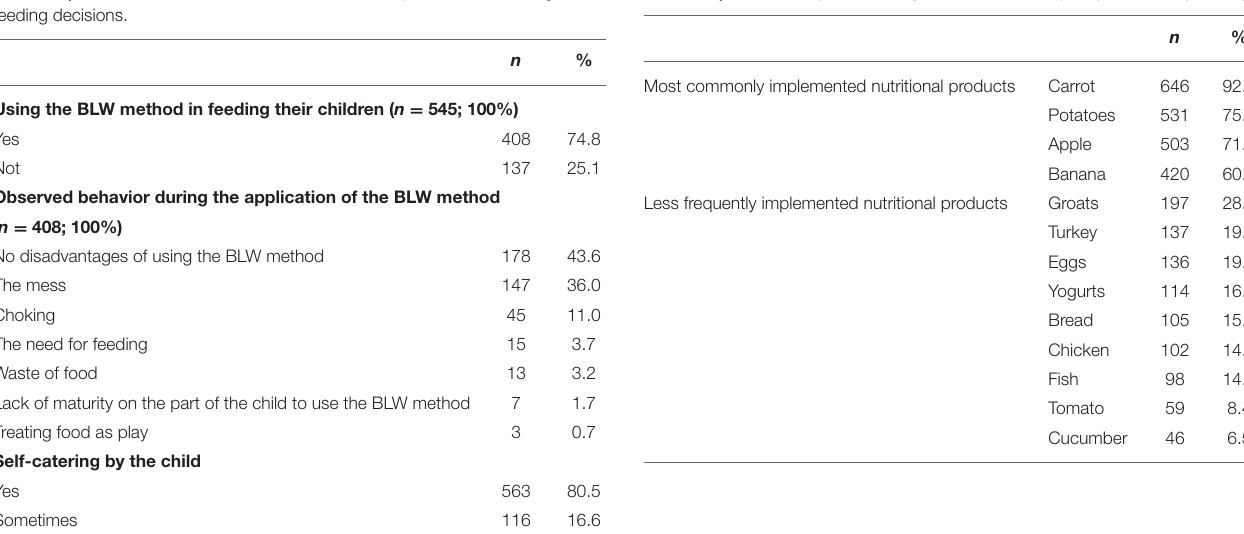
TABLE 7 | Products implemented by the BLW method (multiple choice